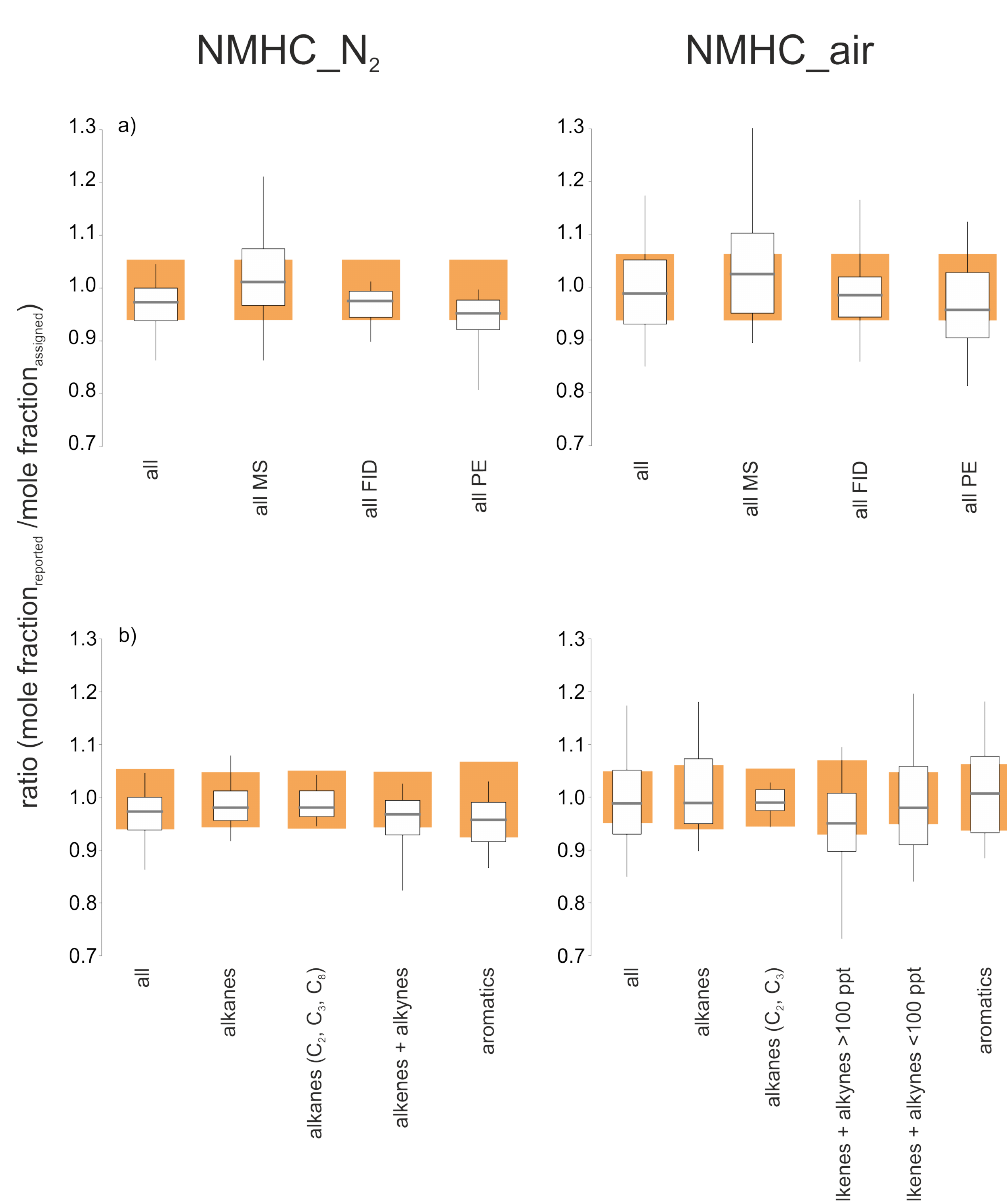
Figure 3. Box plots for NMHC_N 2 (left) and NMHC_air (right) relative to the assigned mole fractions (Table 1). (a) Overview box plot for all results, (b) box plot for the different compound classes, (c) box plot for alkanes, (d) box plot for alkenes and alkynes, (e) box plot for aromatics. The white box stretches from the 25th percentile to the 75th percentile, containing the median in between. The whiskers end at the 10th and 90th percentile. The orange box indicates the 5% class (see Table 2 and Eq. 1). MS: mass spectrometer; FID: flame ionisation detector; PE: